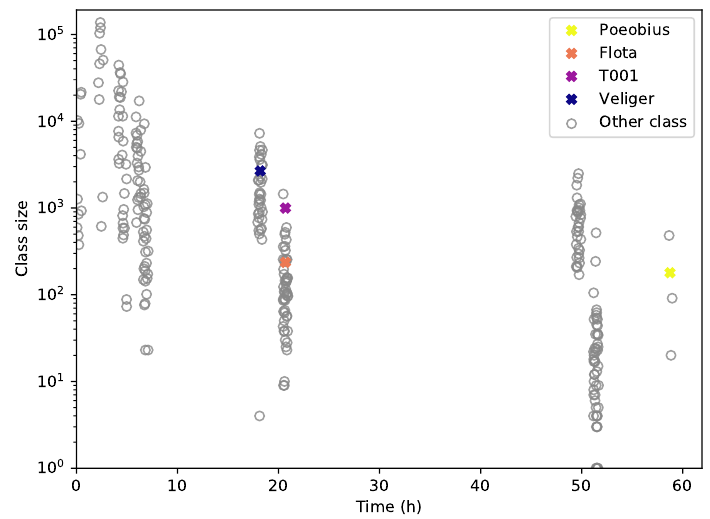
Figure 11. Discovery of classes during the process. The larger a class, the earlier its seed (with at least 5% of the final number of objects) was found, as